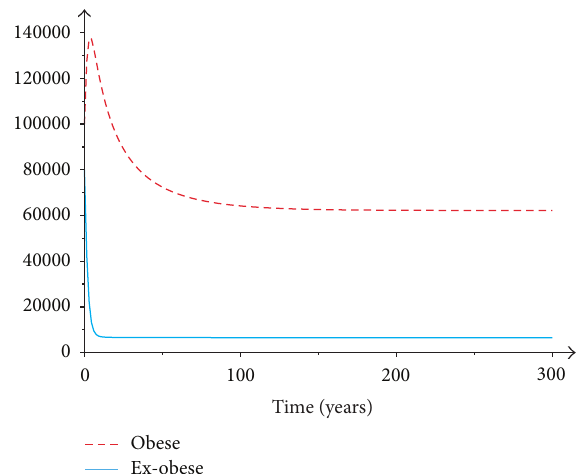
Figure 16: Infected (obese) and recovered (ex-obese) individuals as function of time. Here 𝜖 = 0.012 > 0 and the initial condition is (100000, 50000) .